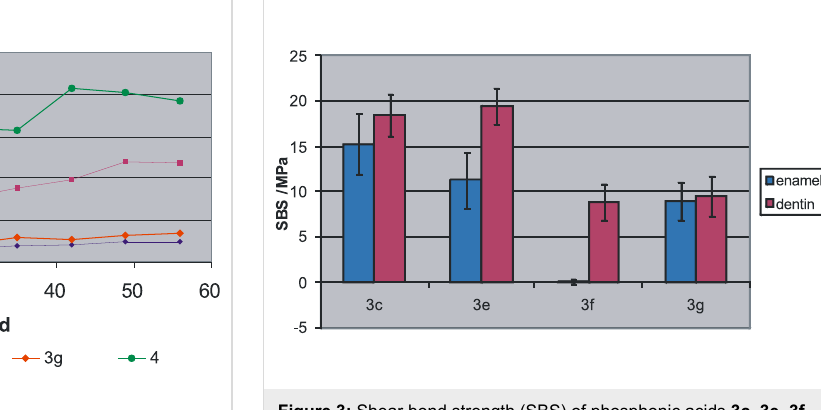
Figure 1: Hydrolysis of N -alkyl- N -(phosphonoethyl) substituted (meth)acrylamides 3 of Scheme 1 and of methacrylic acid phosphono- methyl ester ( 4 ) after storage in aqueous solution at 50 °C.